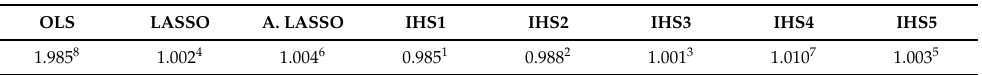
Table 12. Mean square errors for different estimators for cruise-ship-info data (superscript repre- sents